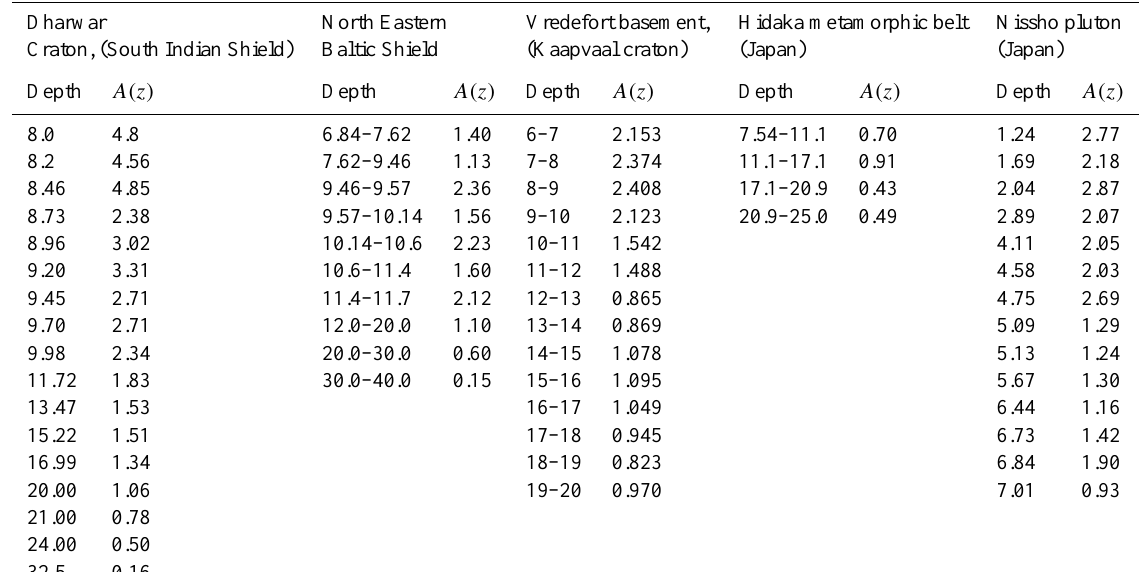
Table 1. Variation of heat production [ A(z) , µWm − 3 ] variation with depth (km) in various continental crustal regions. Dharwar North Eastern Vredefort basement, Hidaka metamorphic belt Nissho pluton Craton, (South Indian Shield) Baltic Shield (Kaapvaal craton) (Japan) (Japan) Depth A(z) Depth A(z) Depth A(z) Depth A(z)